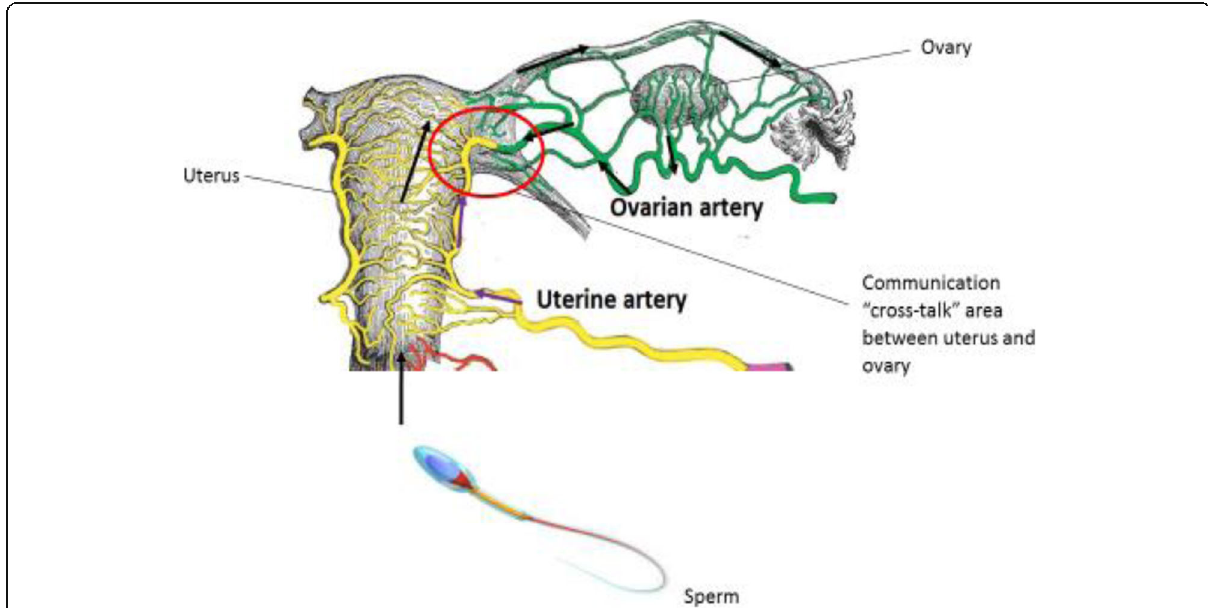
Fig. 2 Schematic diagram showing the communication area between the ovary and uterus providing evidence of vascular counter-current transfer in sperm chemotaxis